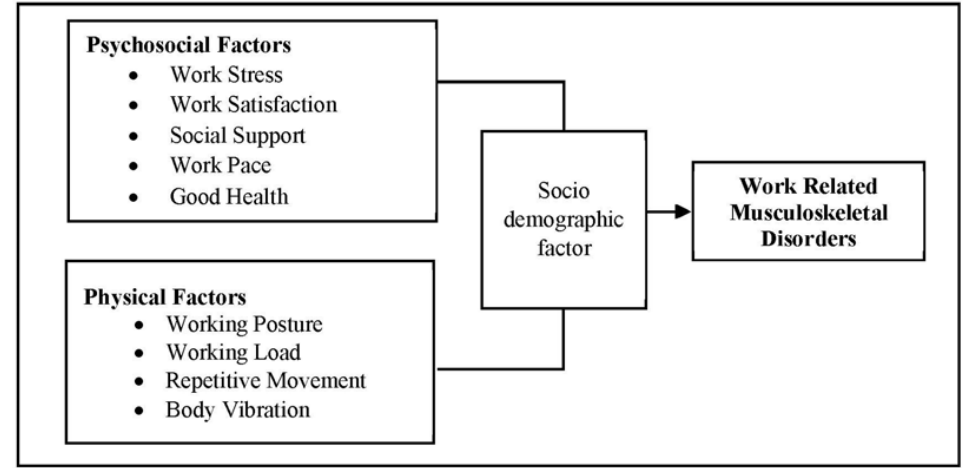
Figure 1. Conceptual framework.